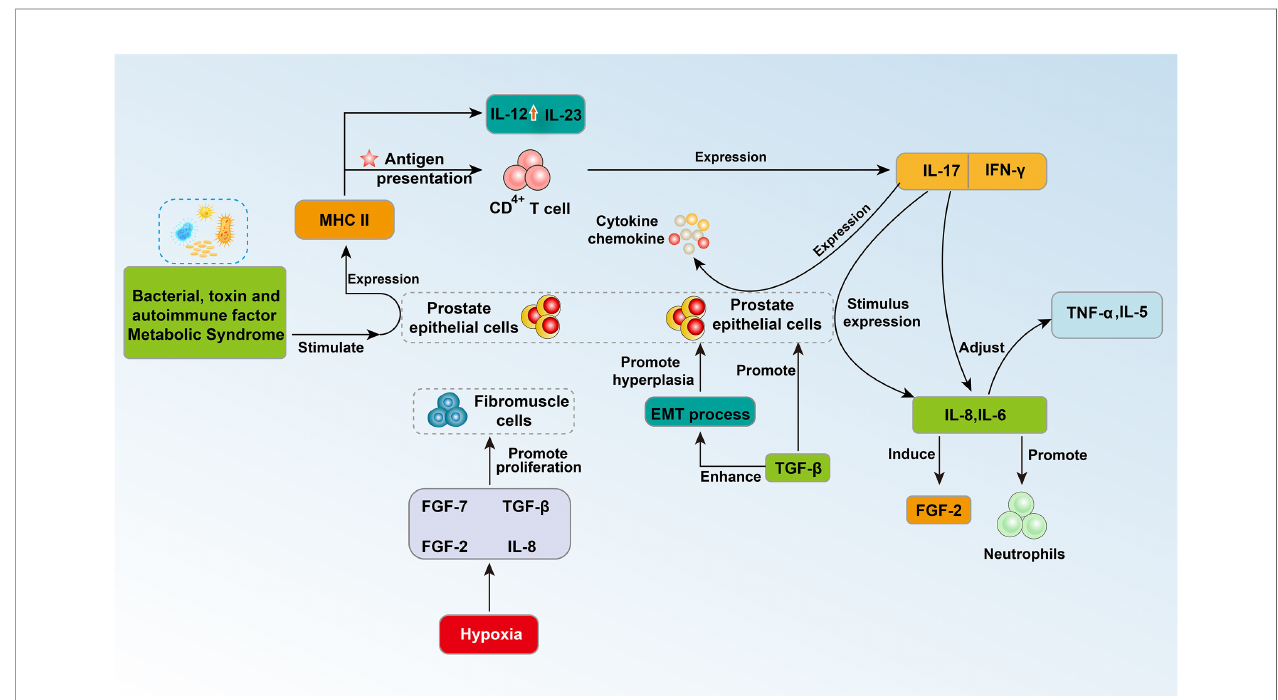
FIGURE 1 | Schematic diagram of the interaction between prostate cells and related cytokines